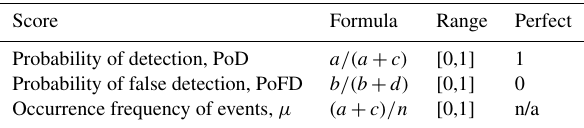
Table 2. Verification measures based on the contingency table.